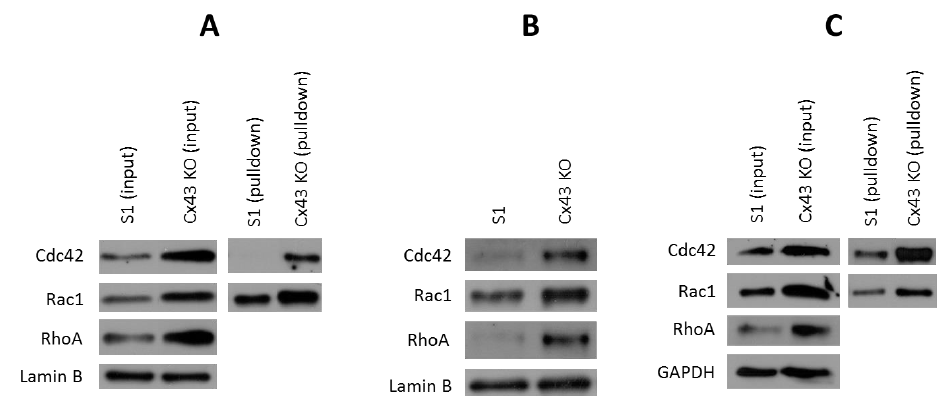
Figure 8. Silencing Cx43 upregulates the expression and activity of Rho GTPases in S1 cells under 2-D and 3-D culture conditions. S1 and Cx43-shRNA S1 cells (Cx43 KO) were cultured under 2-D ( A ), 3-D conditions of undiluted ( B ) or diluted Matrigel (1:5; C ). Total proteins were extracted on day 9 in 2-D ( A ) and on day 11 in 3-D ( B , C ). Expression of RhoA, Cdc42, and Rac1 was assessed by Western blotting. Lamin B and GAPDH served as loading controls. Three independent experiments were performed. Activity of Rho GTPases. Three independent experiments were performed.